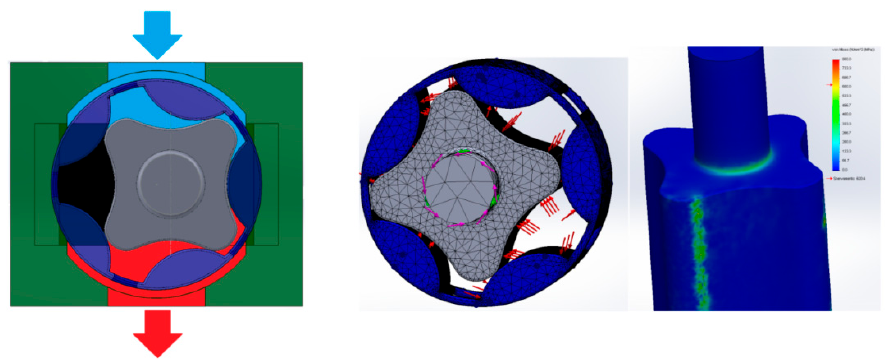
Figure 6. Reference gerotor render, mesh, and FEM result examples.